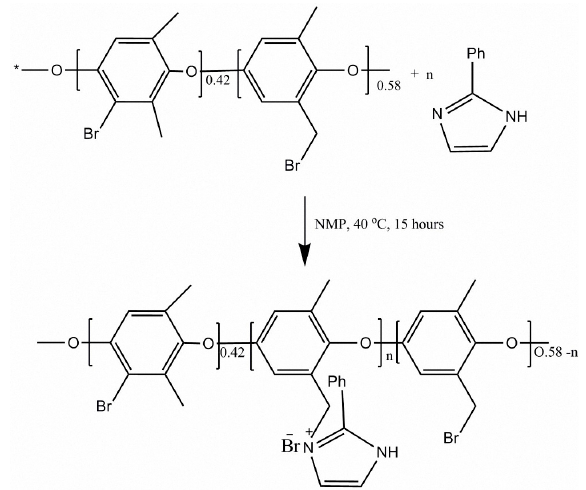
Figure 1. Synthesis of brominated poly-(2,6-dimethyl-1,4-phenyleneoxide) (BPPO)-based anion exchange membranes.